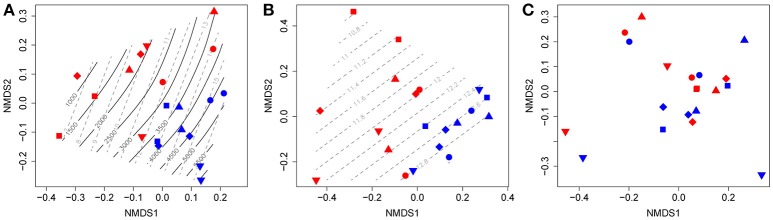
Non-metric multi-dimensional scaling (NMDS) ordination of T-RFLP profiles for (A) collective denitrification genes (nirK, nirS, nosZ-I, and nosZ-II); (B) nitrite-reduction genes (nirK and nirS); and (C) N2O-reduction genes (nosZ-I and nosZ-II). Each point represents the T-RFLP profile of one field plot. Environmental vectors that were significantly correlated to shifts in T-RFLP profiles (p < 0.05) were fitted to the ordination and presented as gradients: black solid lines represent cumulative N2O emissions (g N2O-N ha−1), and gray dashed lines represent average soil NO3- content (mg N kg−1 soil). ∙ : C4-CC+N; ■: O4-CC-N; ♦: O4-CC+N; ▴: O4+CC-N; ▾: O4+CC+N. Red points represent samples from 2011, and blue points those from 2012.